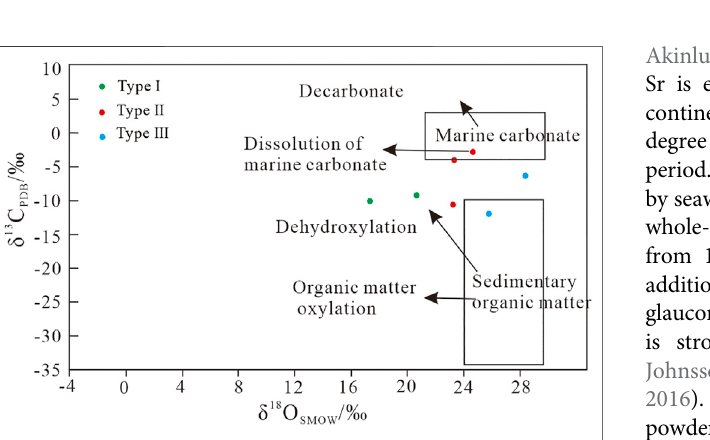
Frontiers in Earth Science |